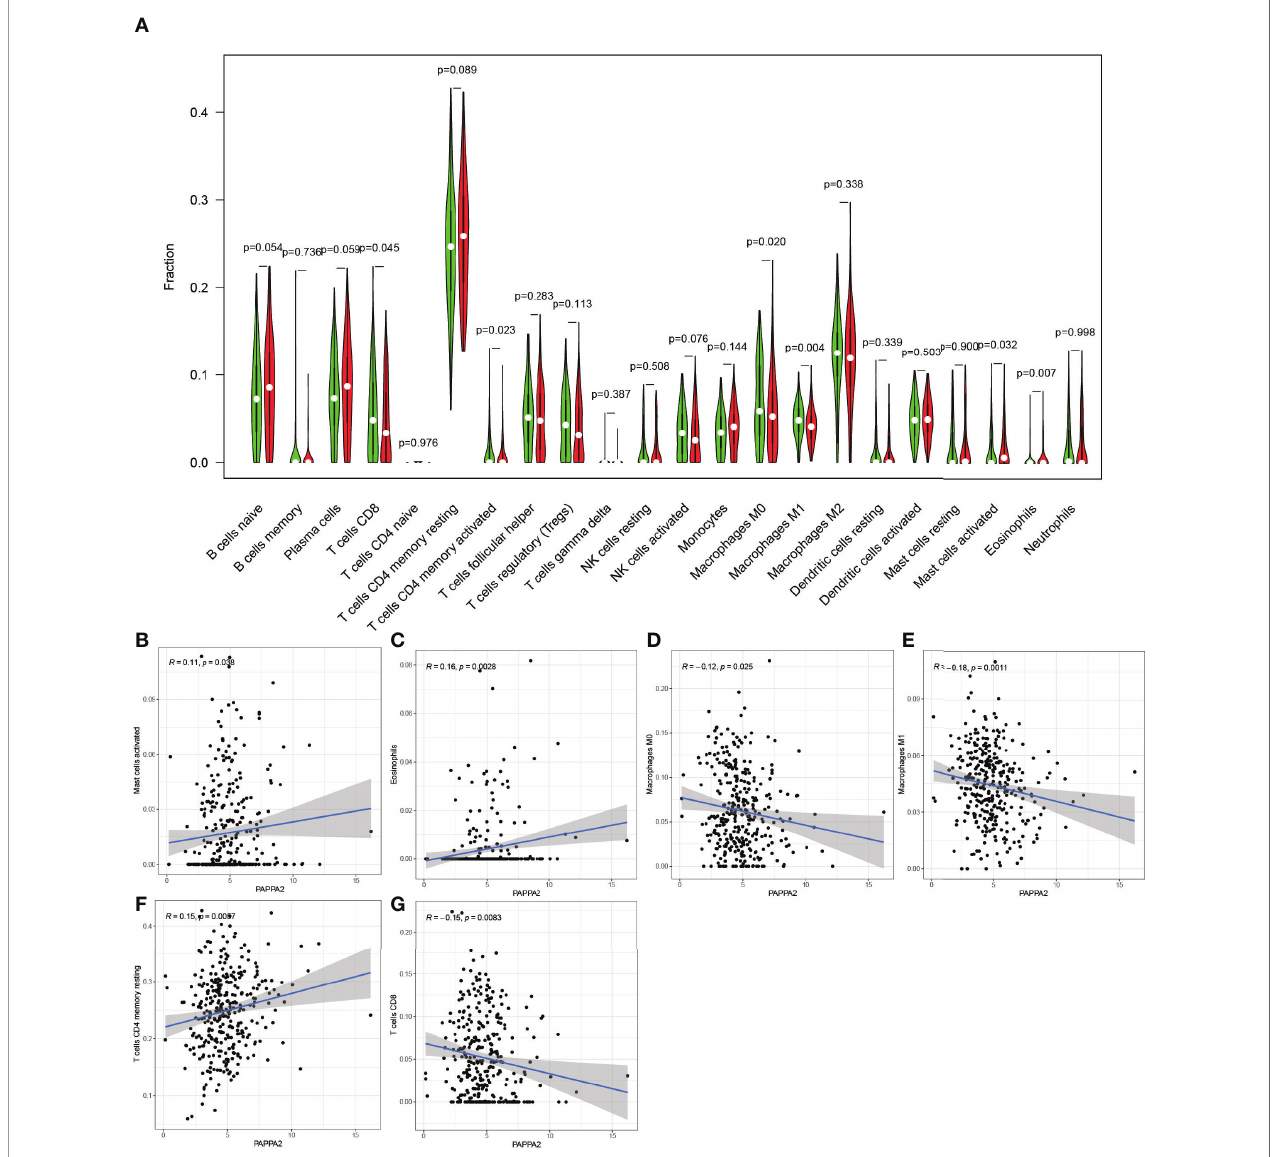
FIGURE 14 | PAPPA2-based immune cell analysis. The (A) graph shows that there are 6 immune cells associated with PAPPA2 in gastric cancer (P-value < 0.05). (B, C, F) plots indicate that these three immune cells are positively correlated with PAPPA2. (D, E, G) plots indicate that these three immune cells are negatively correlated with